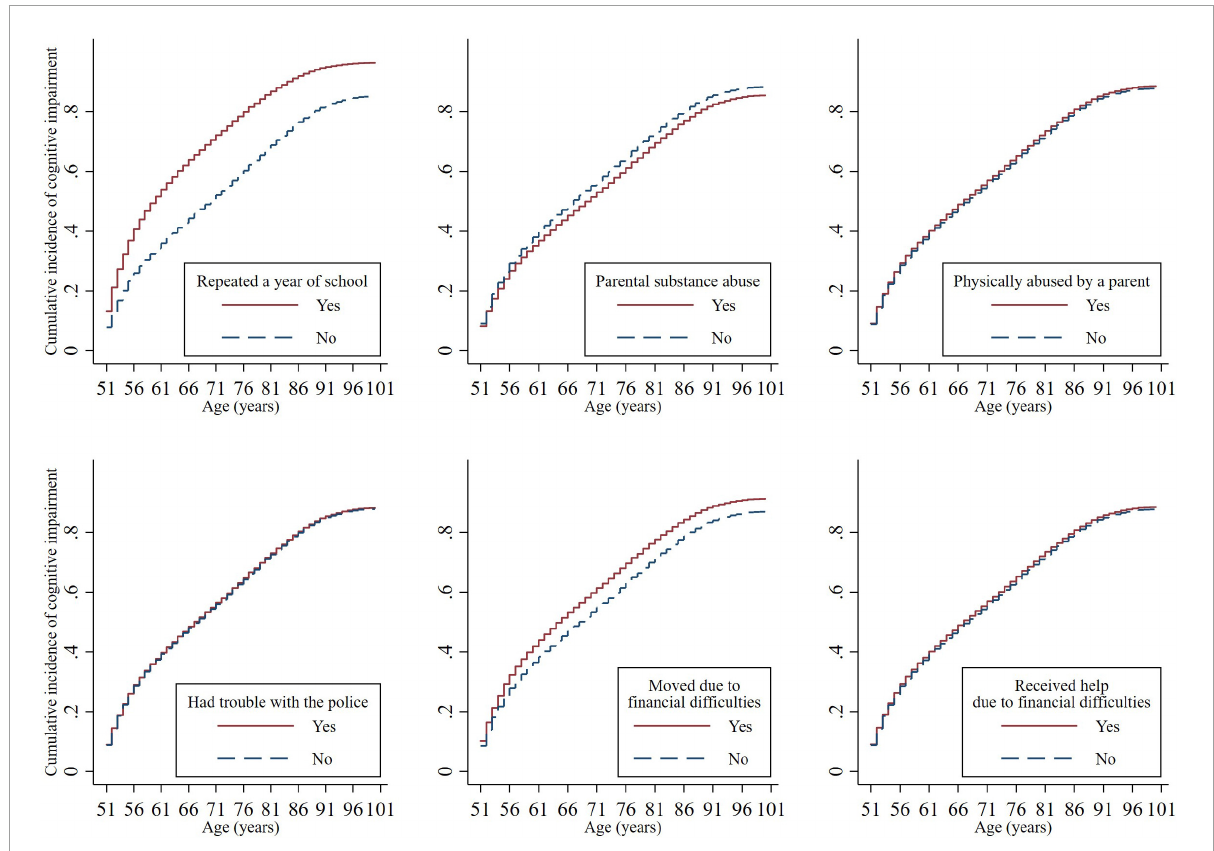
FIGURE1 Cumulative incidence functions for cognitive impairment by childhood adversities. The cumulative incidence of cognitive impairment differed significantly by repeating a year of school (Subdistribution Hazard Ratio [SHR] = 1.74, 95% CI = 1.64–1.85, p < 0.001), parental substance abuse (SHR = 0.90, 95% CI = 0.84–0.96, p = 0.002), and financial difficulties that caused a move (SHR = 1.20, 95% CI = 1.12–1.27, p <